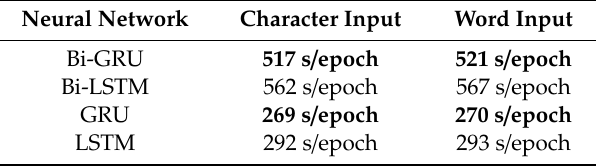
Table 8. The training time of each neural network is compared for di ff erent input models.